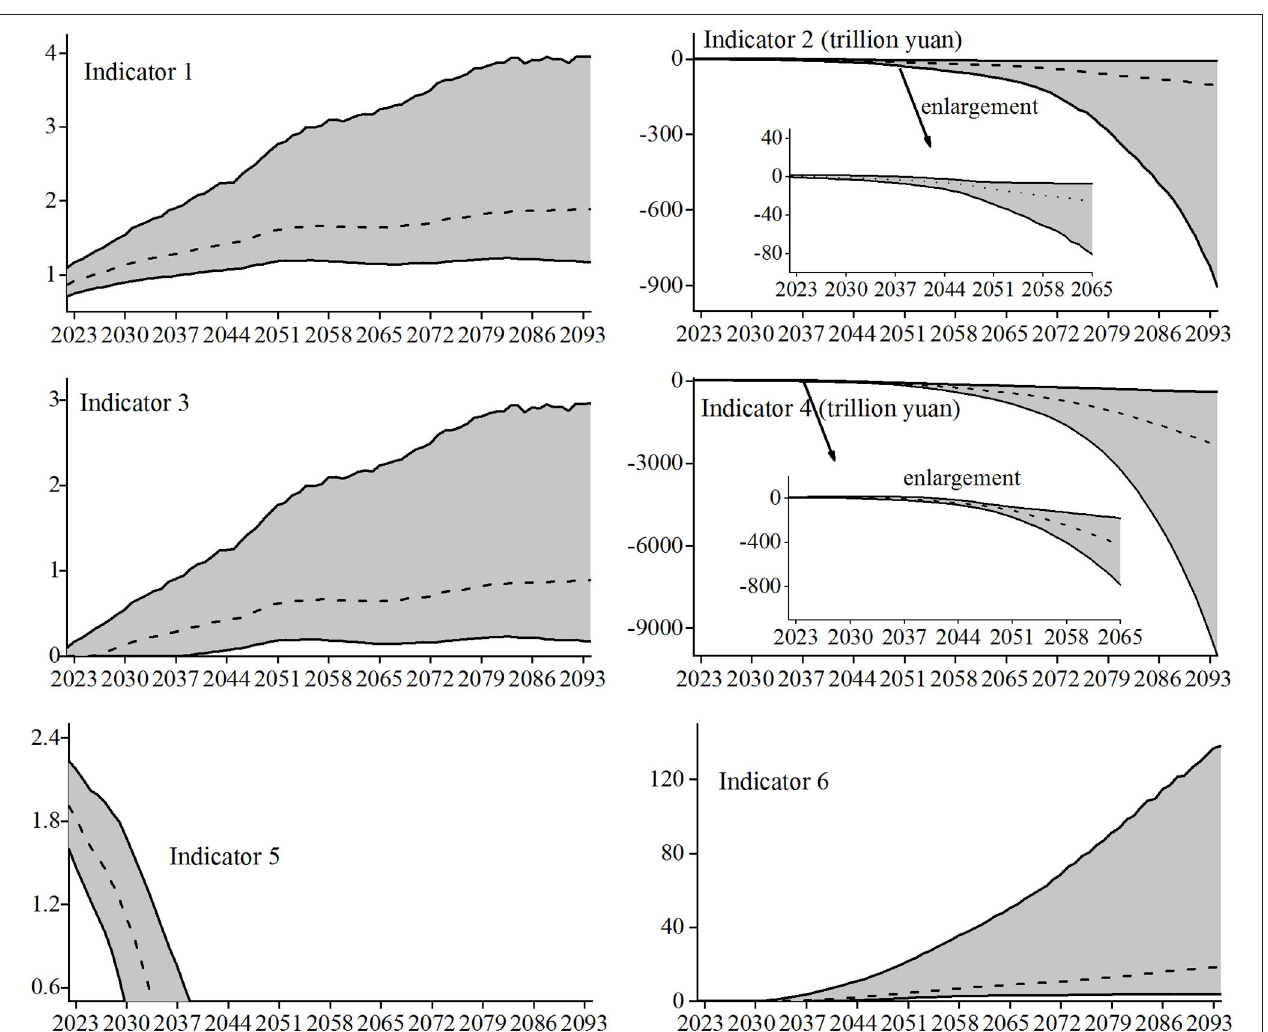
FIGURE 3 | Change trend and confidence interval of long-term fund